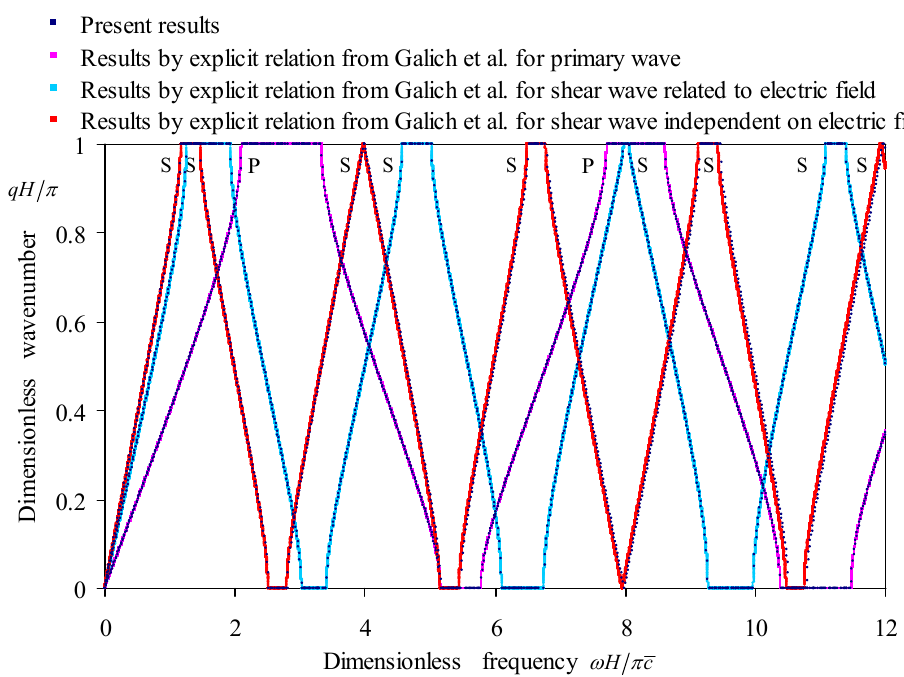
Figure 7. Comparisons of the wavenumber spectra of the exemplified periodic Glass-(PZT-5H 2 ) multilayers in the case of the electric-open boundary computed by the proposed method and by the explicit dispersion relation from Galich et al. [20], as the piezoelectricity of PZT-5H 2 are